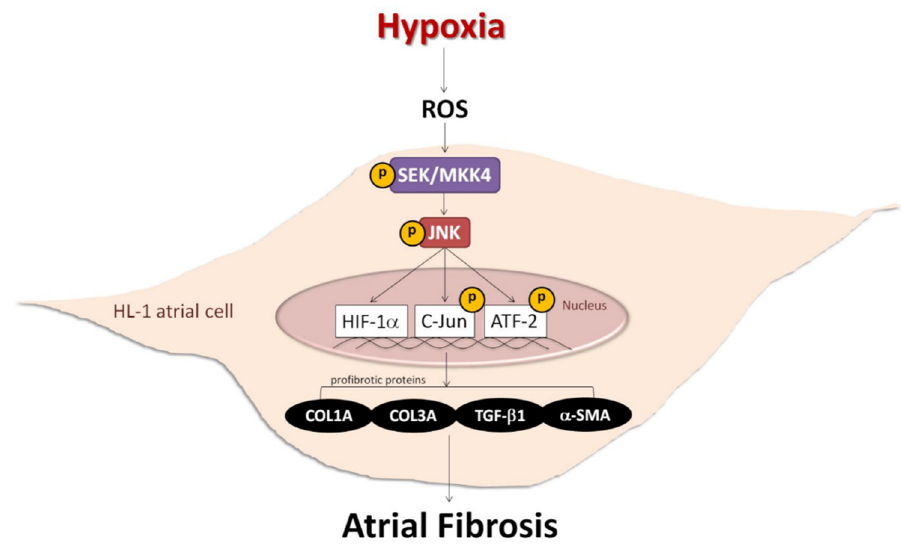
Figure 7. Schematic diagram of hypoxia promoting atrial fibrosis via the ROS/JNK pathway and downstream activation of nuclear c-Jun/ATF2 phosphorylation to up-regulate the expression of fibrosis-related proteins in HL-1 cells.